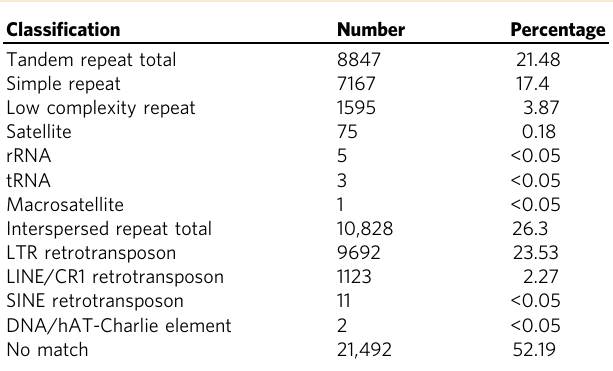
Table 2 Characterization of LR insertions and deletions using